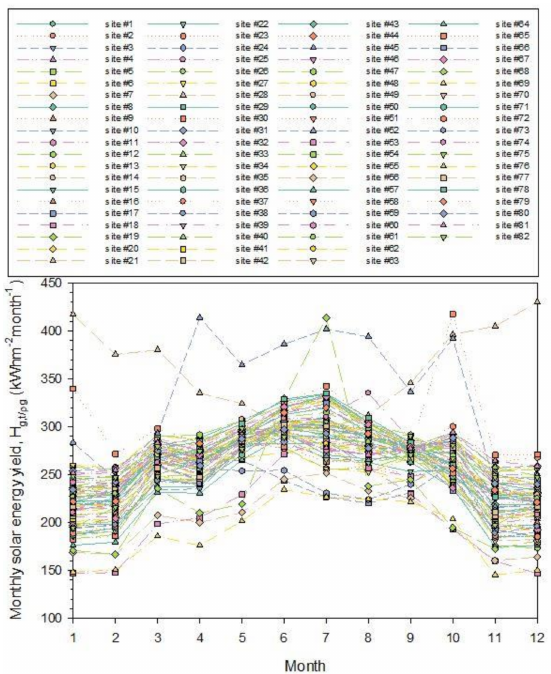
Figure 5. Intra-annual variation of H g,t/ ρ g under all-sky conditions for all 82 sites. The monthly values are sums of the hourly solar radiation ones for each site and averaged over the period 2005–2016. The numbers in the legend correspond to the sites shown in column 1, Table